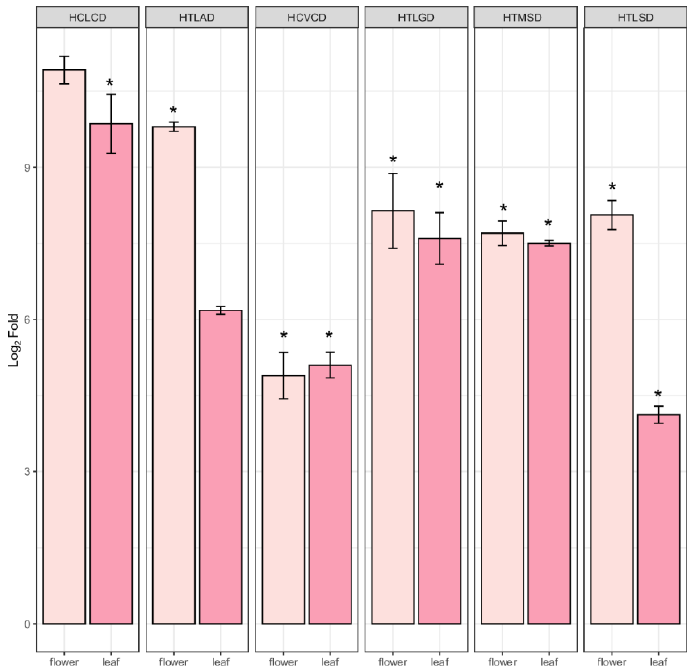
Figure 6. Comparative quantification of PPP unigenes in different plant parts of A. spathulifolius . The error bar indicates the mean of ± SD, and * indicates qRT-PCR changes that are statistically significant by t-test ( p ≤ 0.05). 4CL ; 4-coumarate--CoA ligase, CAA ; coumaroyl-CoA, CCR ; cinnamoyl-CoA reductase, CSE ; caffeoylshikimate esterase; C4H , cinnamic acid 4-hydroxylase; HCT , hydroxycinnamoyl CoA shikimate hydroxycinnamoyl-transferase .